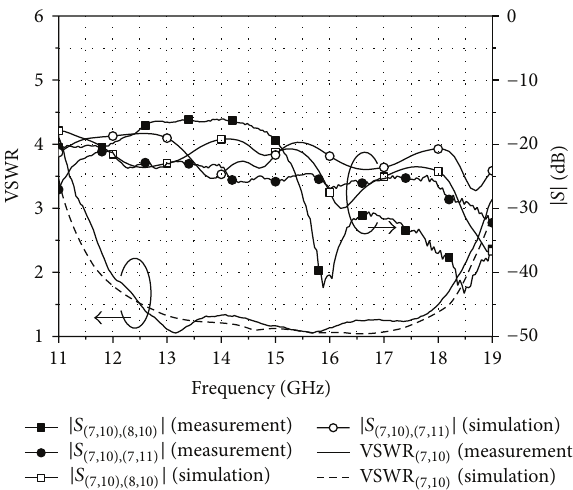
of the embedded element, a great matching performance is achieved. Their values are listed as follows: 𝑊 𝑙𝑥 = 𝐿 𝑙𝑦 = 4.25